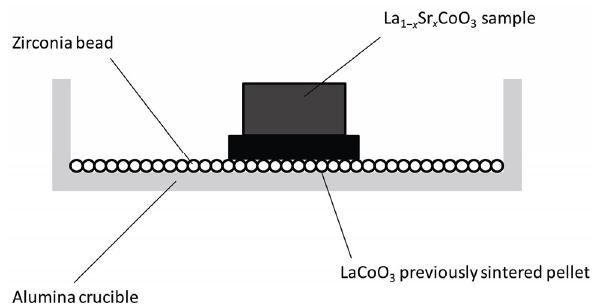
Fig. 1 Schematic representation of the synthesis